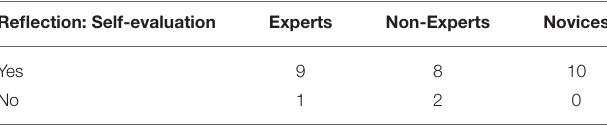
TABLE 7 | An overview of how self-evaluation occurred across the three skill levels.